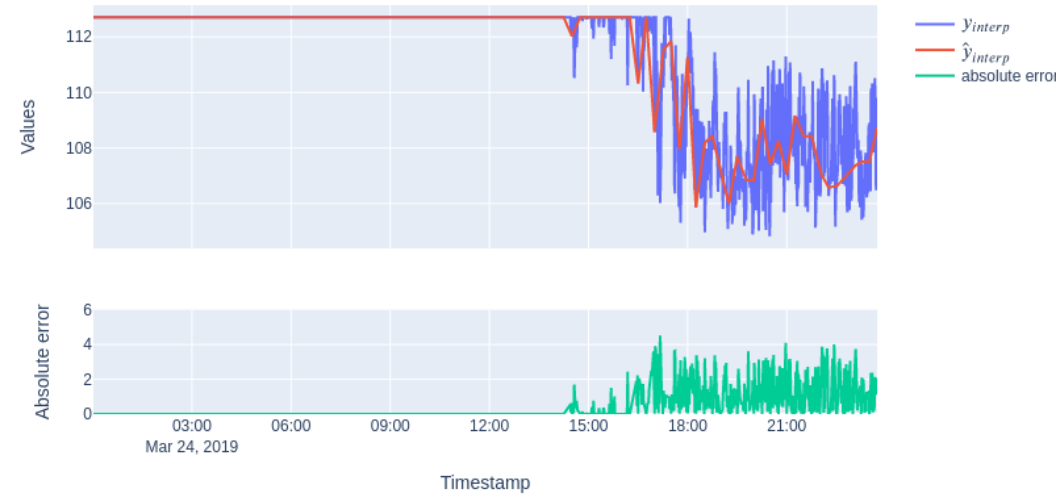
Figure 15. Difference between original data and joined data with a desired time sampling frequency 15 min.